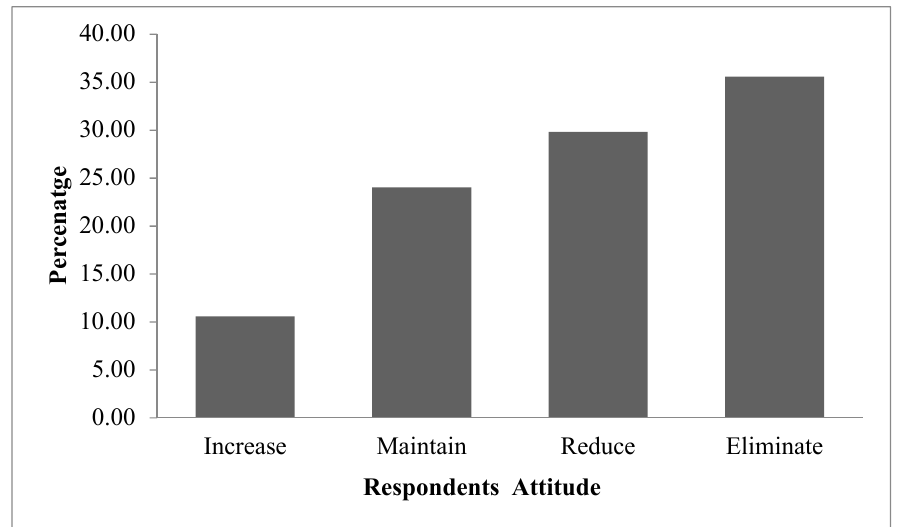
Figure 4. Attitude of respondents towards the grey wolf in Kumrat Valley.